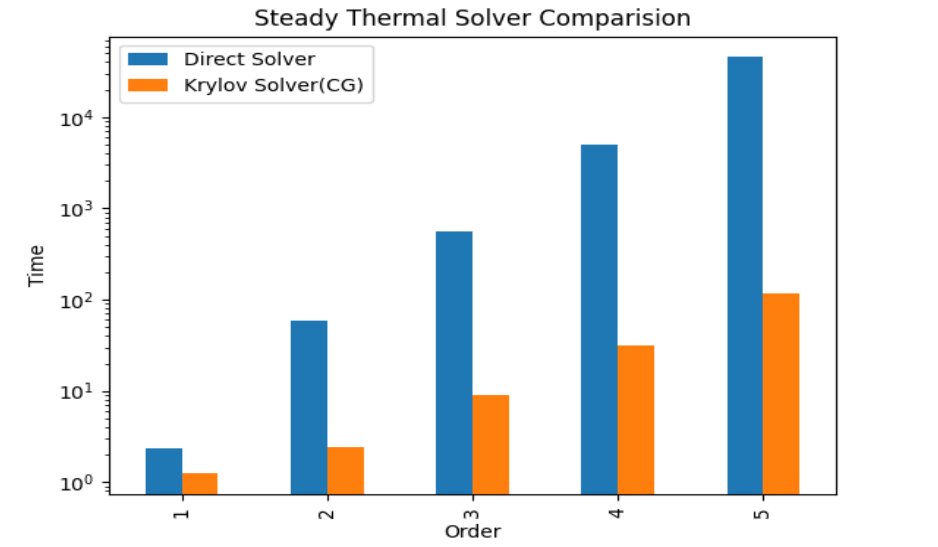
Figure 7. Comparison of execution time between direct and Krylov